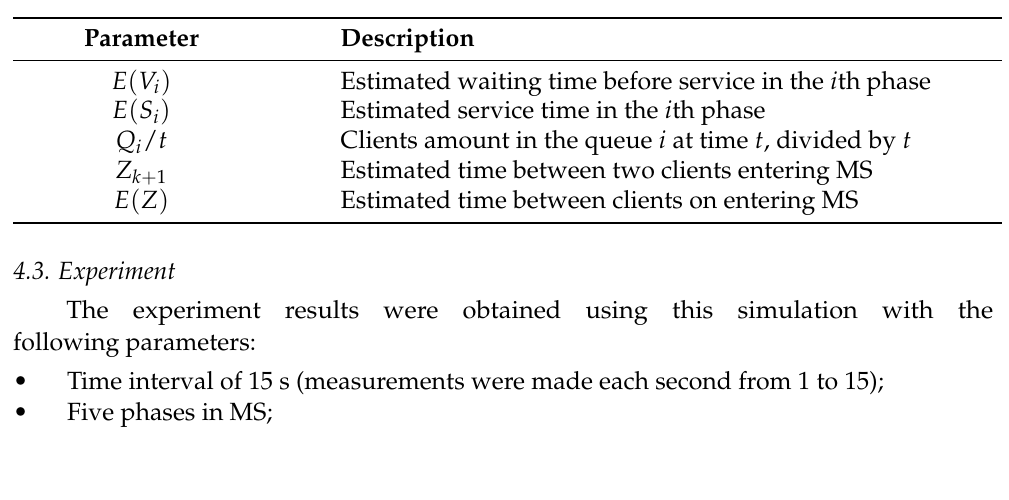
Table 2. Computational parameters of the